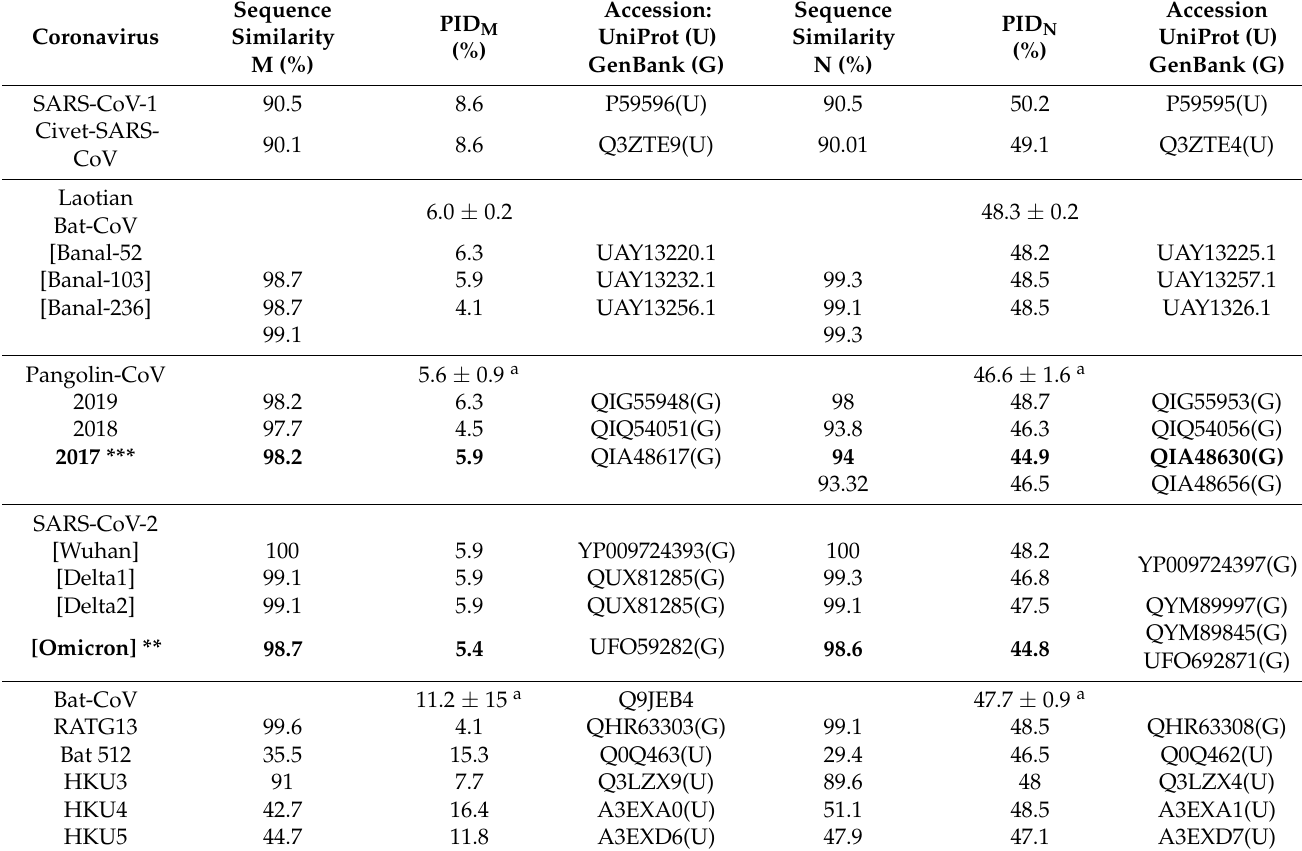
Table 3. Details of the pangolin CoVs and bat CoVs PID M and PID N values and their sequence similarities with SARS-Co-V and SARS-CoV-2 as references. Using PID N , wo sub-variants of Delta were detected using SDM (Delta1, Delta2) [21]. Data from COVID-19-related bat-CoVs have been added. (Taken in part from Biomolecules. 2022;12(5). © 2022 Goh et al, Published by MDPI AG, Open access under CC BY-NC-ND license. This is an Open Access article which permits unrestricted non-commercial use, provided the original work is properly cited.